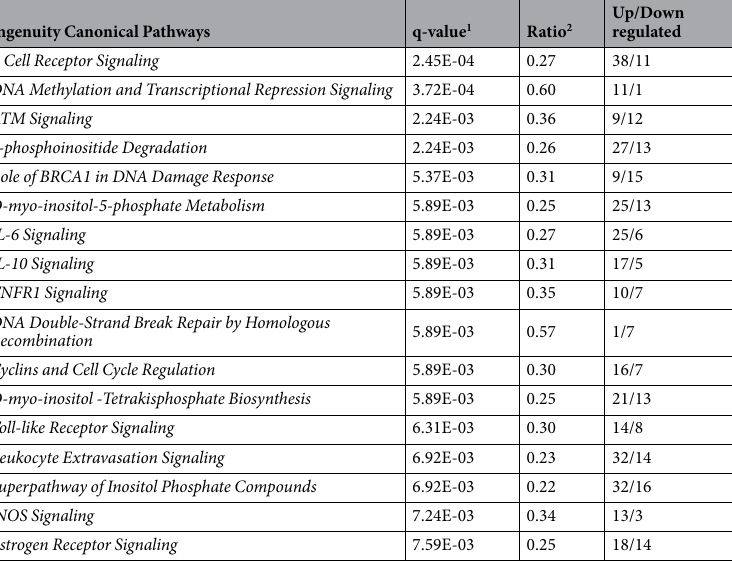
Table 2. Top canonical and signaling pathways among Differentially Expressed Genes (DEGs) in early response (H + 8) to the inflammatory challenge with a q-value < 0.01 and a ratio > 0.1. 1 The q-value shows the significance of the enrichment of a function within the DEGs, adjusted by Benjamini and Hochberg’s FDR. 2 Ratio of DEGs/number of genes in the